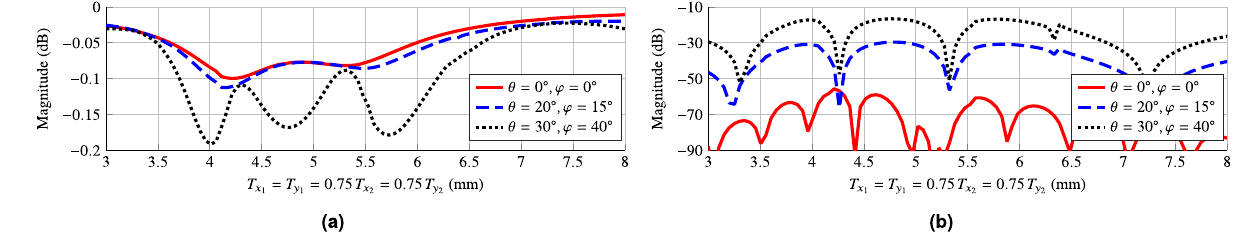
Figure 6. Magnitude response of the unit cell at 17 GHz for different angles of incidence for the ( a ) direct coefficient and ( b ) cross-coefficient. The losses remain low and stable for low oblique incidence while the cross- polarization increases with the angle of incidence.